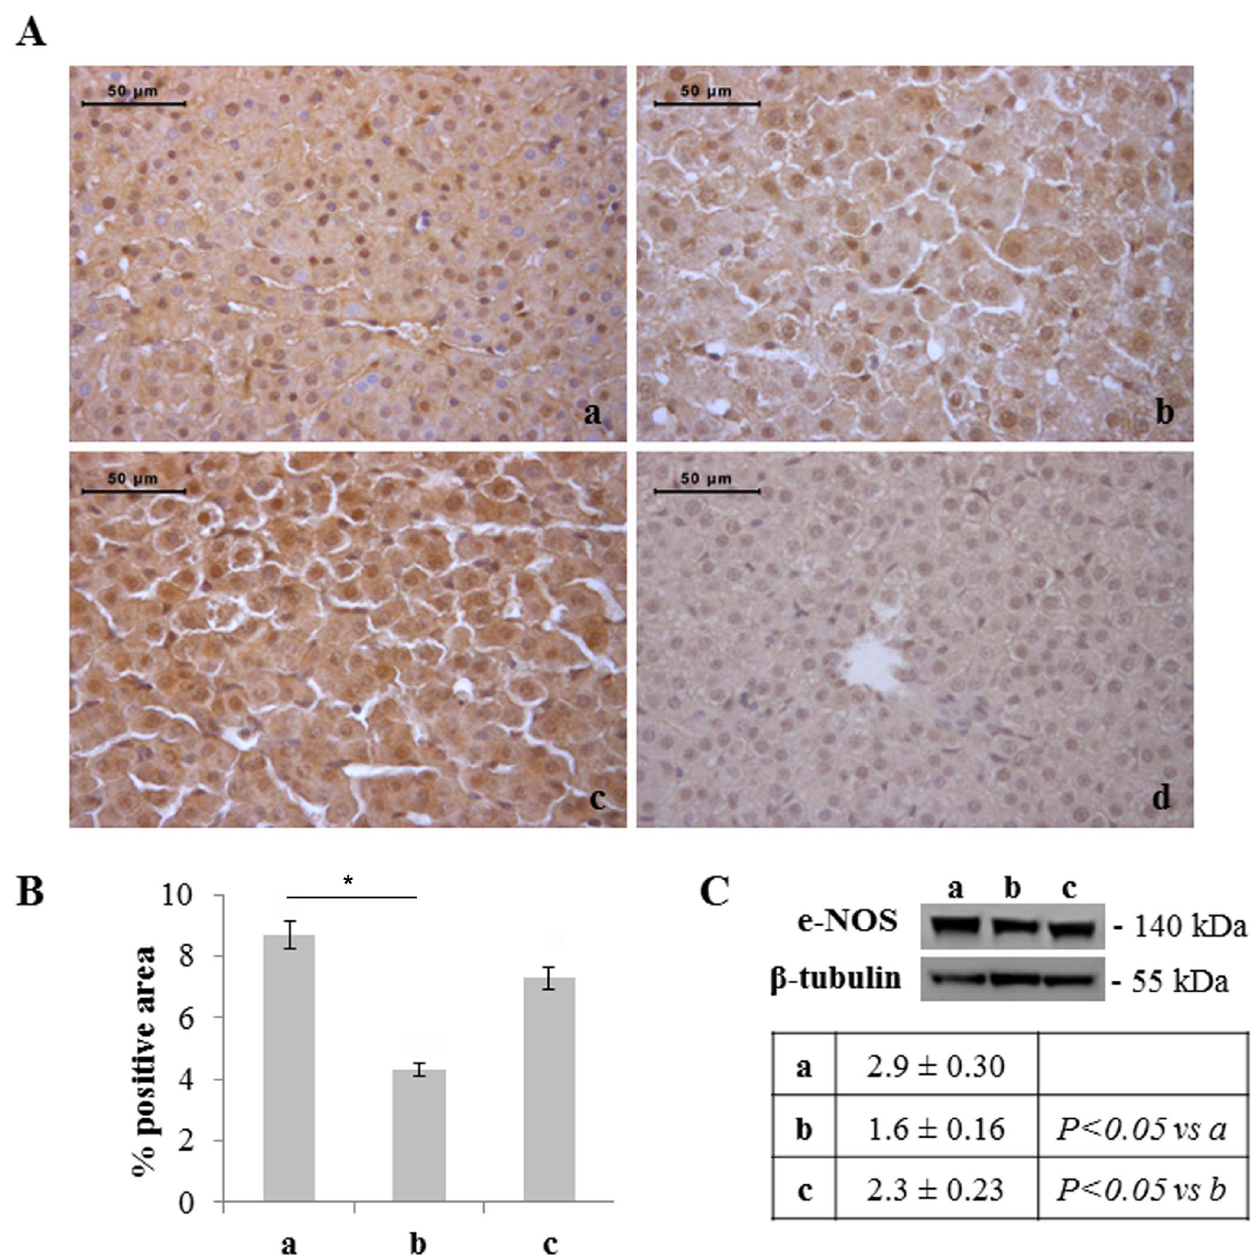
Figure 8. Moderate hyperoxia reduces hepatocyte eNOS expression with respect to normoxia and severe hyperoxia. A) Immunohistochemical detection of eNOS expression in neonatal rat livers exposed to moderate and severe hyperoxia. a) ambient air; b) 60% hyperoxia; c) 95% hyperoxia; d) negative control; scale bar: 50 m m, magnification 40x. B) Graphic representation of the percentage of eNOS positive area ( 6 SD); densitometric analysis determined by direct visual counting of ten fields for each of three slides per sample. *=p , 0.05. C) Western blotting analysis of eNOS expression in neonatal rats. Each membrane has been probed with anti b -tubulin antibody to verify loading evenness. The most representative out of three separate experiments is shown. Data are the densitometric measurements of protein bands expressed as mean values of Integrated Optical Intensity (IOI) ( 6 SD). doi:10.1371/journal.pone.0105005.g008 percentage of NF-kB positive hepatocyte nuclei was significantly lower in rats exposed to 60% hyperoxia than in controls and rats exposed to 95% hyperoxia (Fig. 10). Significant changes were not observed in the percentages of NF-kB positive liver haemopoietic cells of the different experimental groups (data not shown).